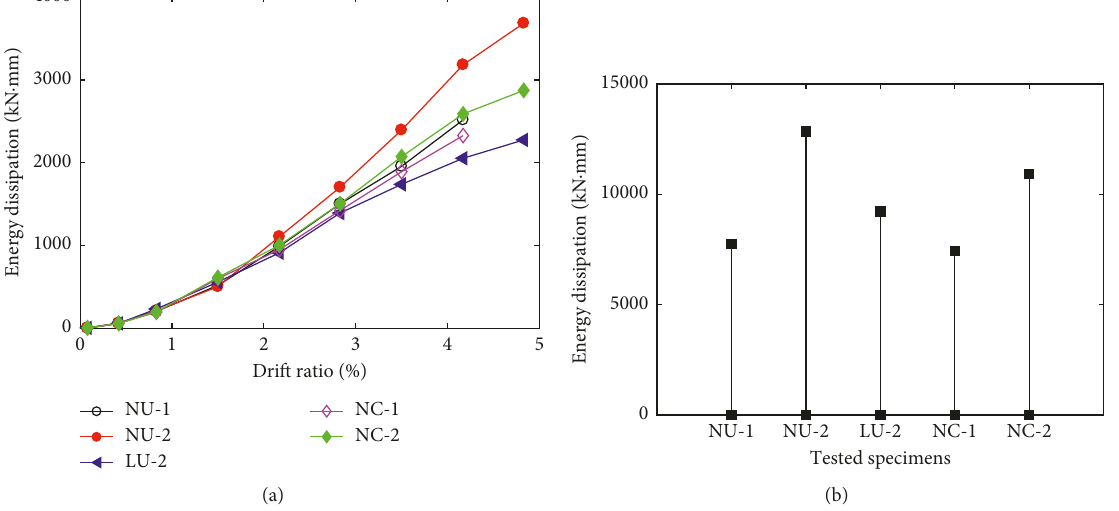
Figure 9: Energy dissipation analysis: (a) energy dissipation E